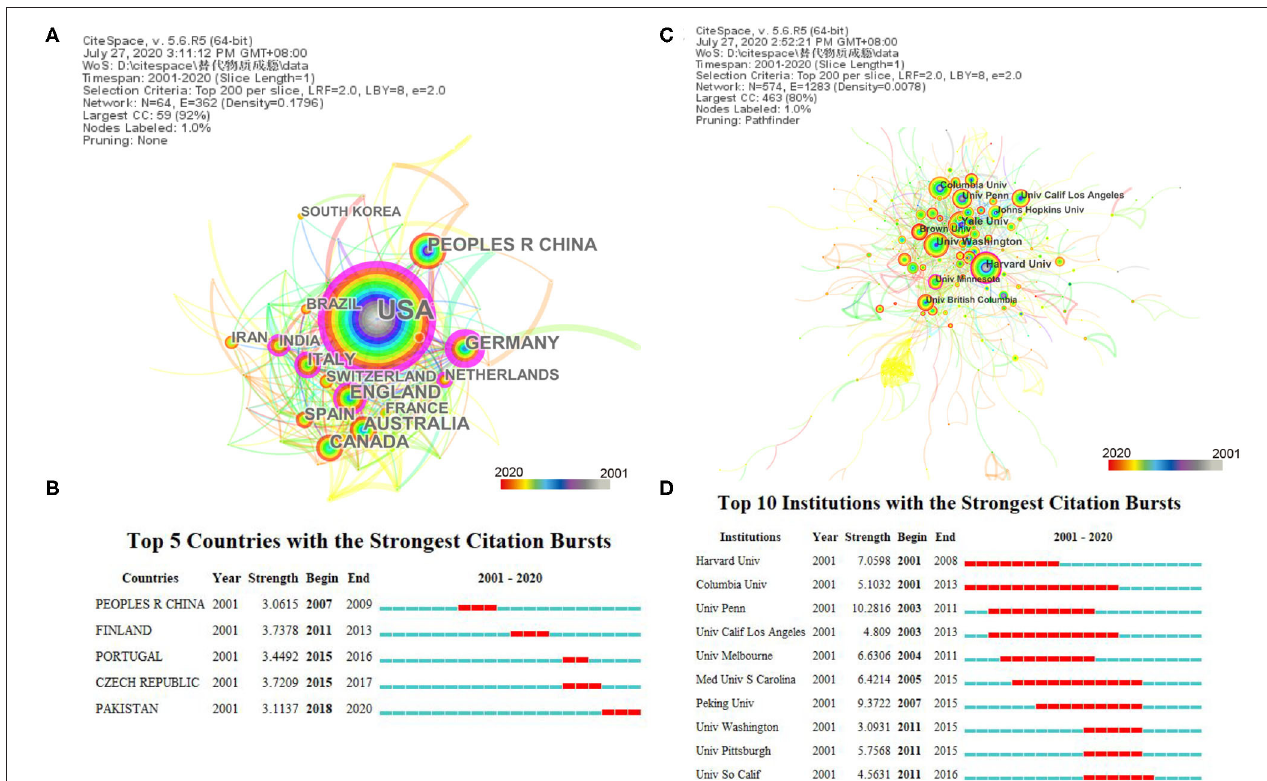
FIGURE 3 | Visualization of complementary and alternative medicine (CAM) for substance use disorders (SUDs) by country and institution. (A) The network map of countries and regions for CAM for SUDs. A total of 64 countries or regions were involved, including 64 nodes and 362 links. (B) Top 5 countries with the strongest citation bursts. (C) The network map of CAM for SUDs by institutions. A total of 574 institutions participated in the publication, including 574 nodes and 1,283 links. (D) Top 10 institutions with the strongest citation bursts. (A,C) Top 15 results shown by time slice on 1 year, and different color presents different year as the legend shows. The nodes consist of an annual ring by different colors as legend, and the thickness of the annual ring represents the number of publications at the corresponding time. There is a purple ring in the outermost layers of some nodes, indicating that the node with high centrality may be a central node. (B,D) Each bar presents each year from 2001 to 2020. The red bar indicates that the institution had frequent citation bursts, and the blue bar indicates that the institution had infrequent citation